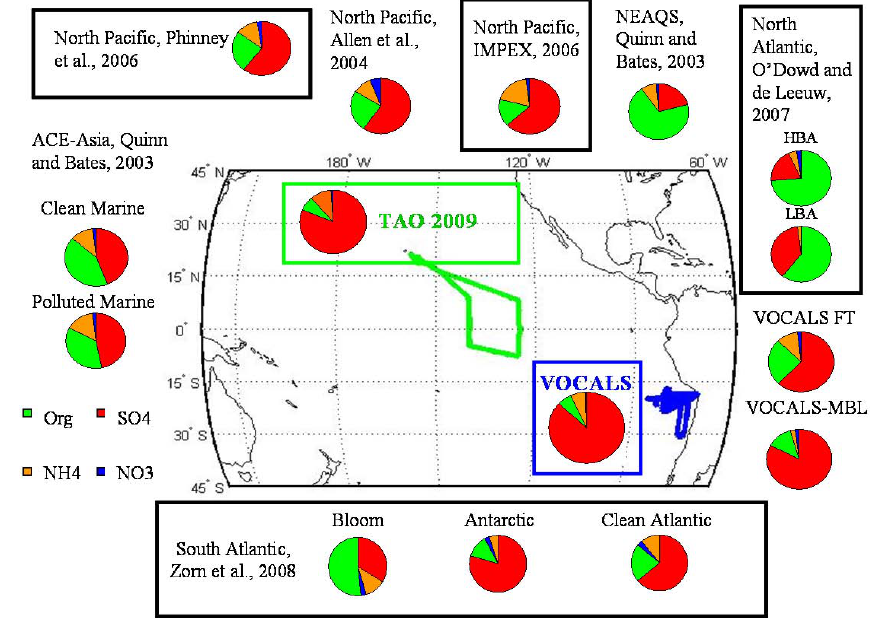
Fig. 1. Study region for VOCALS (blue) and TAO 2009 cruise (green). Pie charts indicate relative contributions of submicron non-refractory species. All studies are of marine boundary layer aerosols, with the exception of the VOCALS Free Troposphere data (FT). Studies in bold boxes indicate those which focus on “clean” marine aerosol, (i.e. based upon various approaches to minimize continental influence). NEAQS=New England Air Quality Study, HBA=High Biological Activity, LBA=Low Biological